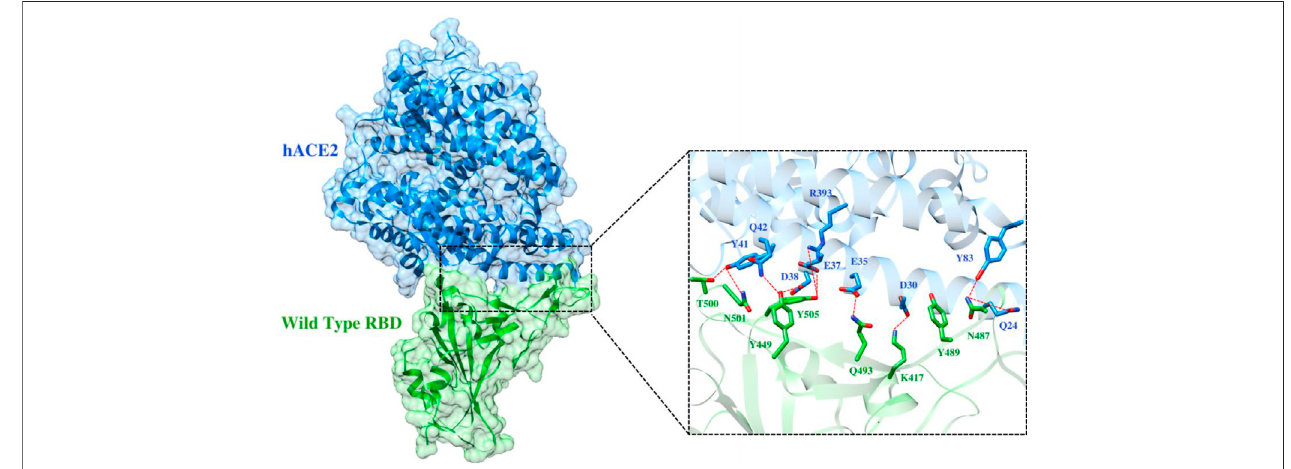
FIGURE5| Interfacialbindinginteractions betweenWT RBDand ACE2 receptor. RBD and ACE2residues arecoloredasgreen and bluesticks,respectivelywhile red dotted lines represent the hydrogen bonds.